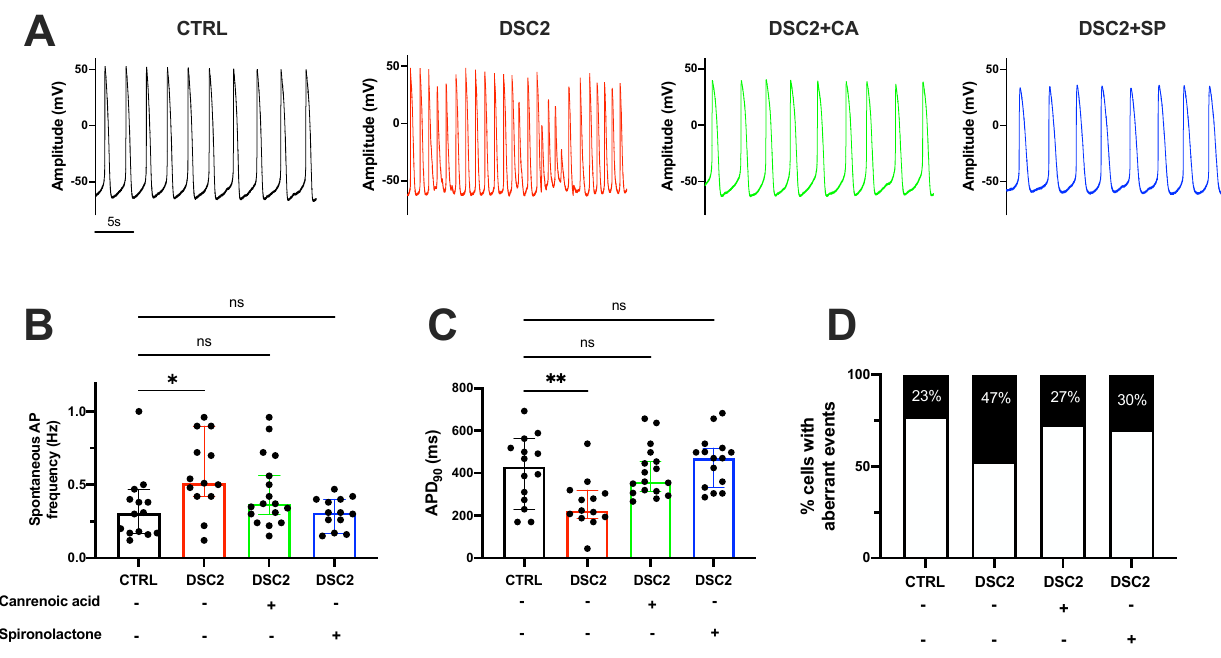
Figure 2. Effect of Canrenoic Acid and Spironolactone on the Action Potential parameters of DSC2 hiPSC − CM. ( A ) Raw traces of spontaneous AP in the control condition (black) ( n = 14), mutated DSC2 (red) ( n = 13), after incubation of 10 nM CA (green) ( n = 18), and after incubation of 20 µ M SP (blue) ( n = 15). ( B ) Values of spontaneous frequency and ( C ) values of action potential duration at 90% repolarization. ( D ) Percentage of the number of cells presenting aberrant electrical events. Results are shown with the median and 95% confidence interval. The stars * correspond to the difference from the control. ns not statically significant, * p < 0.05, ** p < 0.01 (Kruskal–Wallis test).